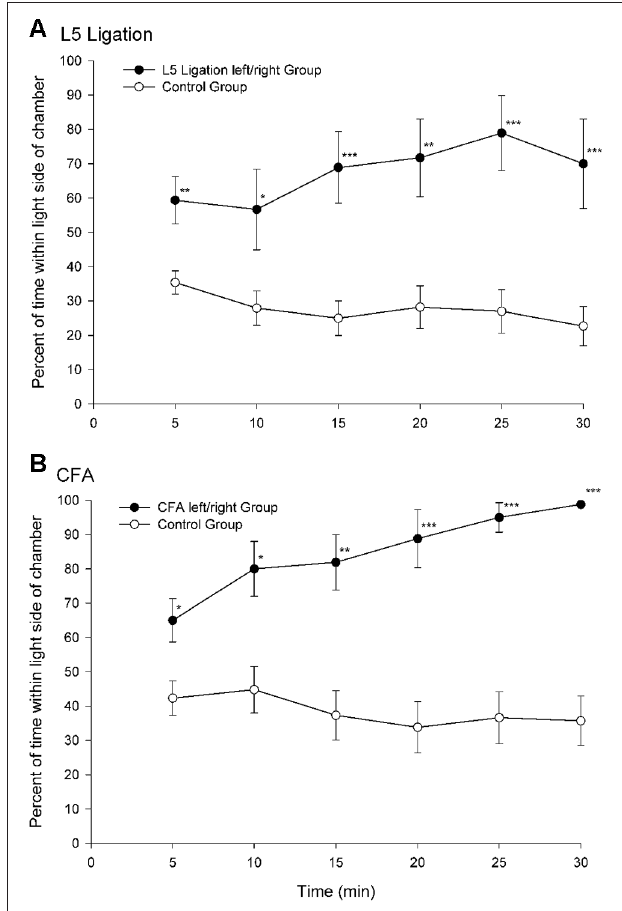
FIGURE 1 | Percentage of time (mean ± SEM) for each 5 min test interval spent in the light side of the test chamber for animals following peripheral nerve damage (L5 ligation, A) or inflammation (subcutaneous complete Freund’s adjuvant (CFA), B) . When mechanical stimulation of the ligated or inflamed paw was associated with the preferred dark area of the chamber animals spend more time in the light area of the chamber indicating that the animals find stimulation of the hypersensitive paw aversive (Reprint from LaBuda and Fuchs,